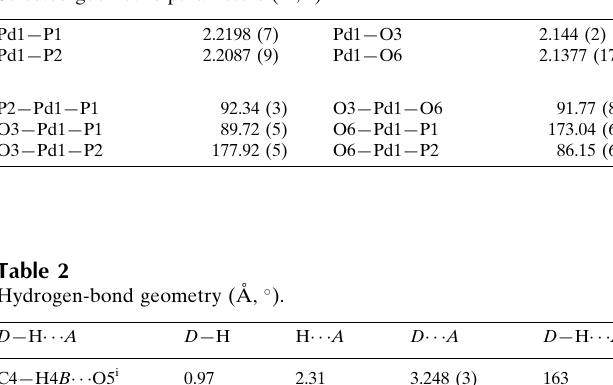
Selected geometric parameters (A˚ , (cid:2) ).